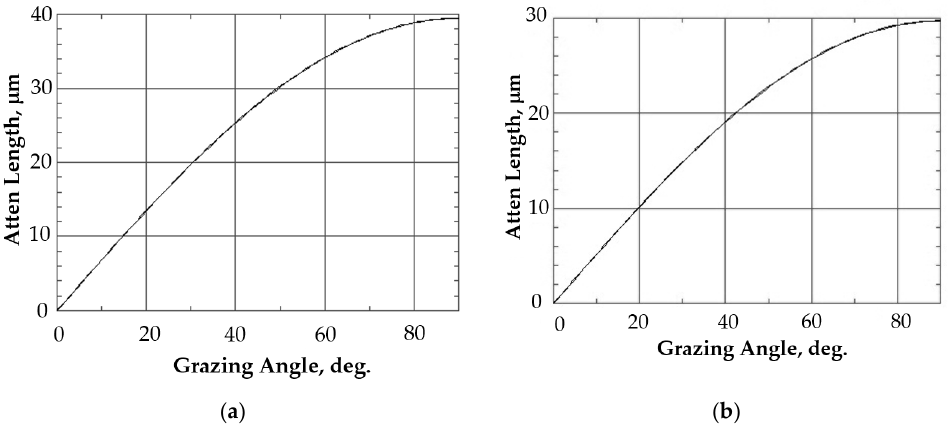
Figure 1 . Calculating the depth of CuKα X -ray radiation penetration into the Na 0.5 Zr 2 (PO 4 ) 2.5 (MoO 4 ) 0.5 Figure 1. Calculating the depth of CuK α X-ray radiation penetration into the Na 0.5 Zr 2 (PO 4 ) 2.5 (MoO 4 ) 0.5 ( a ) and Na 0.5 Zr 2 (PO 4 ) 2.5 (WO 4 ) 0.5 ( b ) specimens depending on α incidence angle. Energy = 8000